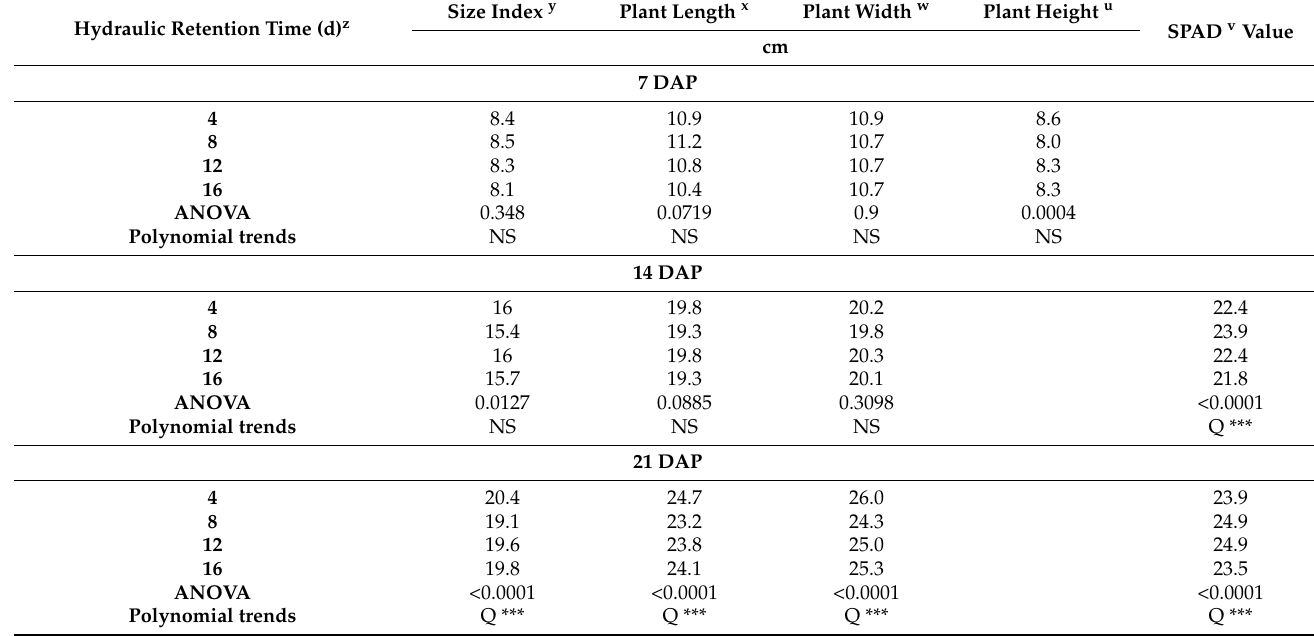
Table 5. Size index and SPAD of ‘Rex’ butterhead lettuce ( Lactuca sativa ) HRT with iron supplementa- tion, simple effects of HRT at measurement